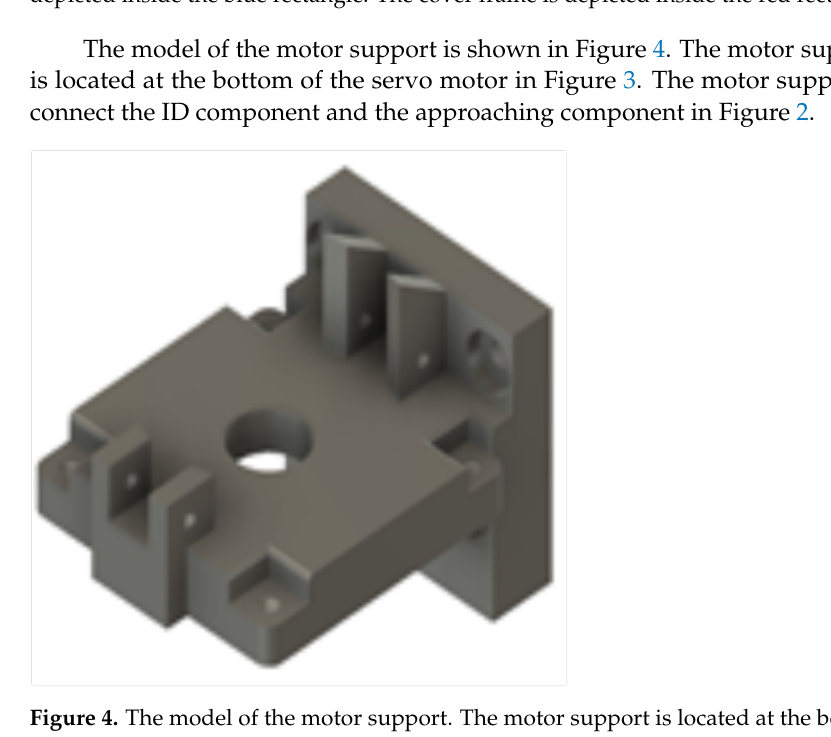
Figure 3. Model of the ID component. In order to show the parts inside the ID component, the model is plotted translucently. The ID shaft component generates the ID’s vertical motion from the rotational motion of the servo motor. The servo motor is depicted inside the green rectangle. The rotary shaft is depicted inside the blue rectangle. The cover frame is depicted inside the red rectangle.